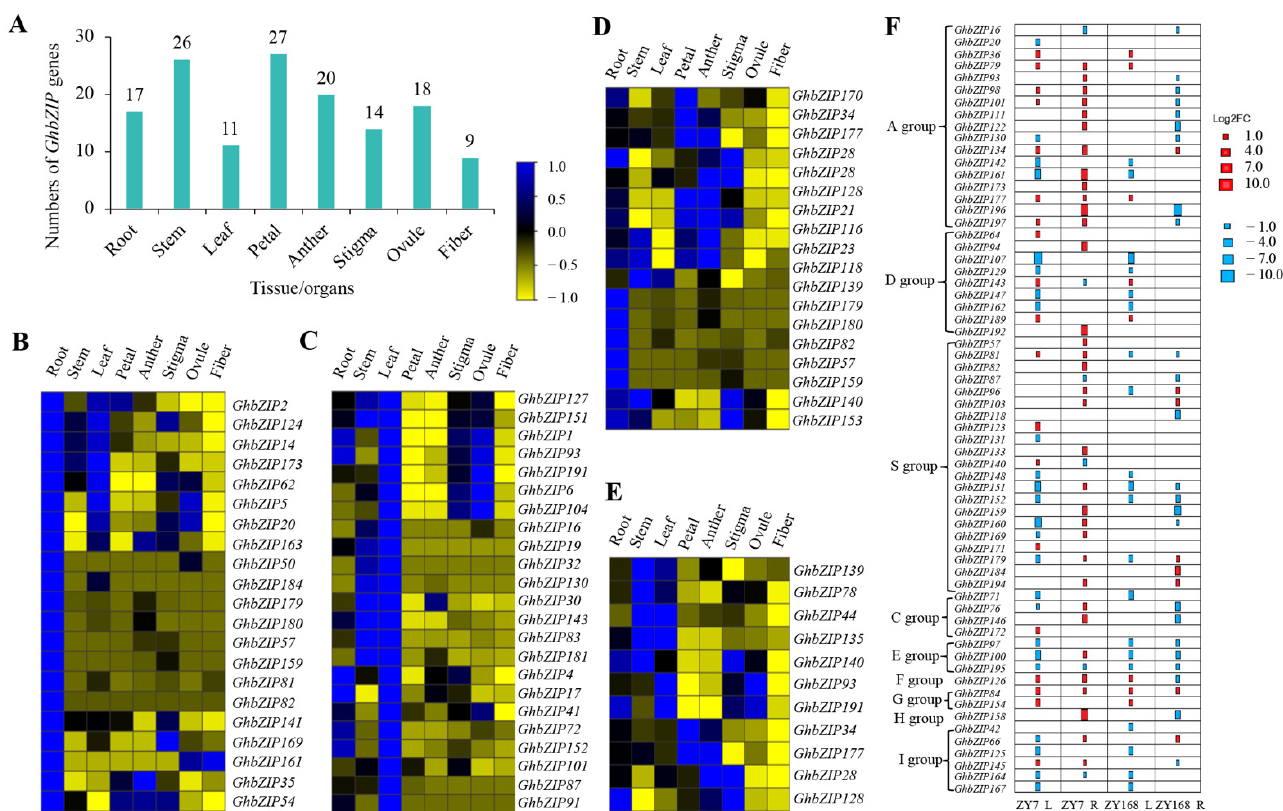
Figure 7. Expression analysis of GhbZIP genes. ( A ) The number of highly expressed GhbZIP genes (FPKM ≥ 20) in different tissues/organs. The expression of GhbZIP family members in different tissues/organs were investigated using transcriptome datasets of G. hirsutum . ( B ) Heat-map of 21 preferentially expressed GhbZIP genes in root. ( C ) Heat-map of 23 preferentially expressed GhbZIP genes in leaf. ( D ) Heat-map of 17 highly expressed GhbZIP genes in root. ( E ) Heat-map of 12 highly expressed GhbZIP genes in root. ( F ) Heat-map of 64 differentially expressed GhbZIP genes under drought stress in leaf and root of seedling stage in drought-sensitive variety ZY7 and drought-tolerant variety ZY168.